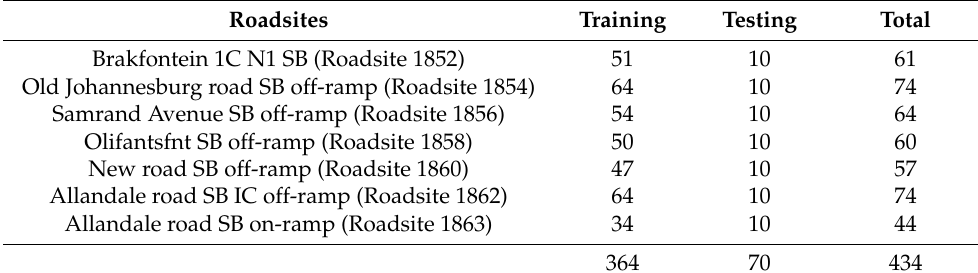
Table 5. The Breakdown of the Roadsites traffic datasets for ANN-PSO